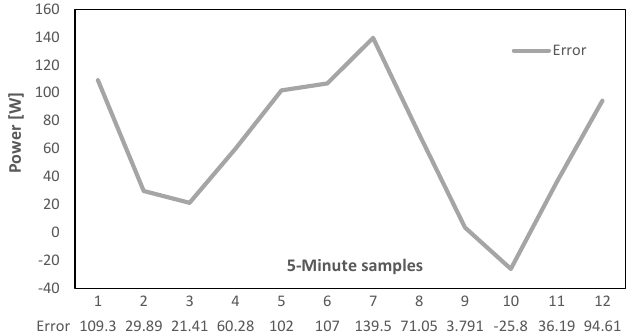
Figure 16. Error due to utilizing forecasted values, first case.